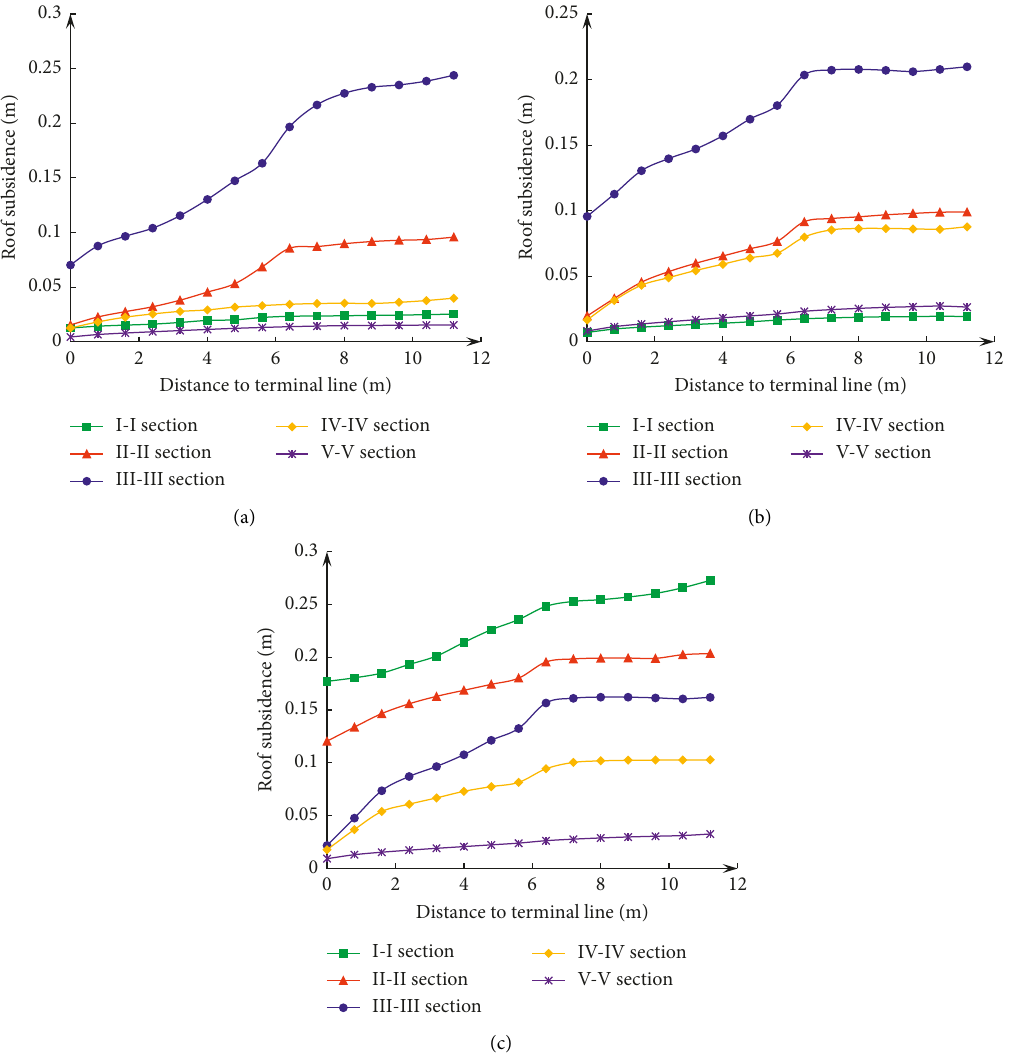
Figure 21: Roof subsidence curves of Stage II. (a) Scheme 1. (b) Scheme 2. (c) Scheme 3. Scheme 1